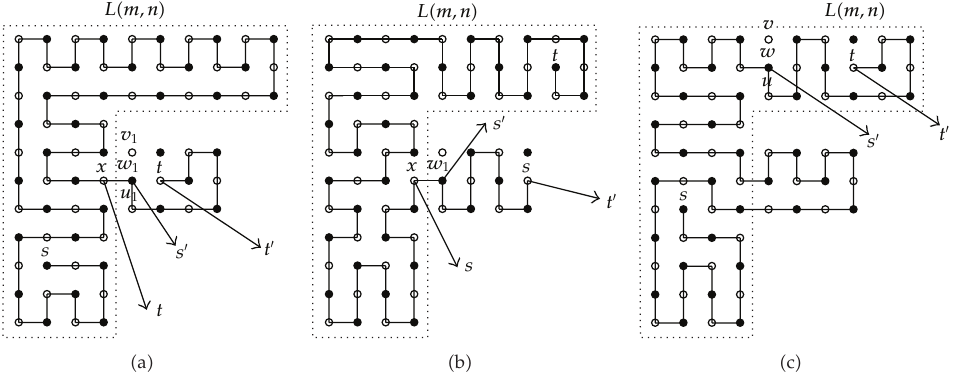
Figure 9: F -alphabet grid graphs in which there is no Hamiltonian path between s and t